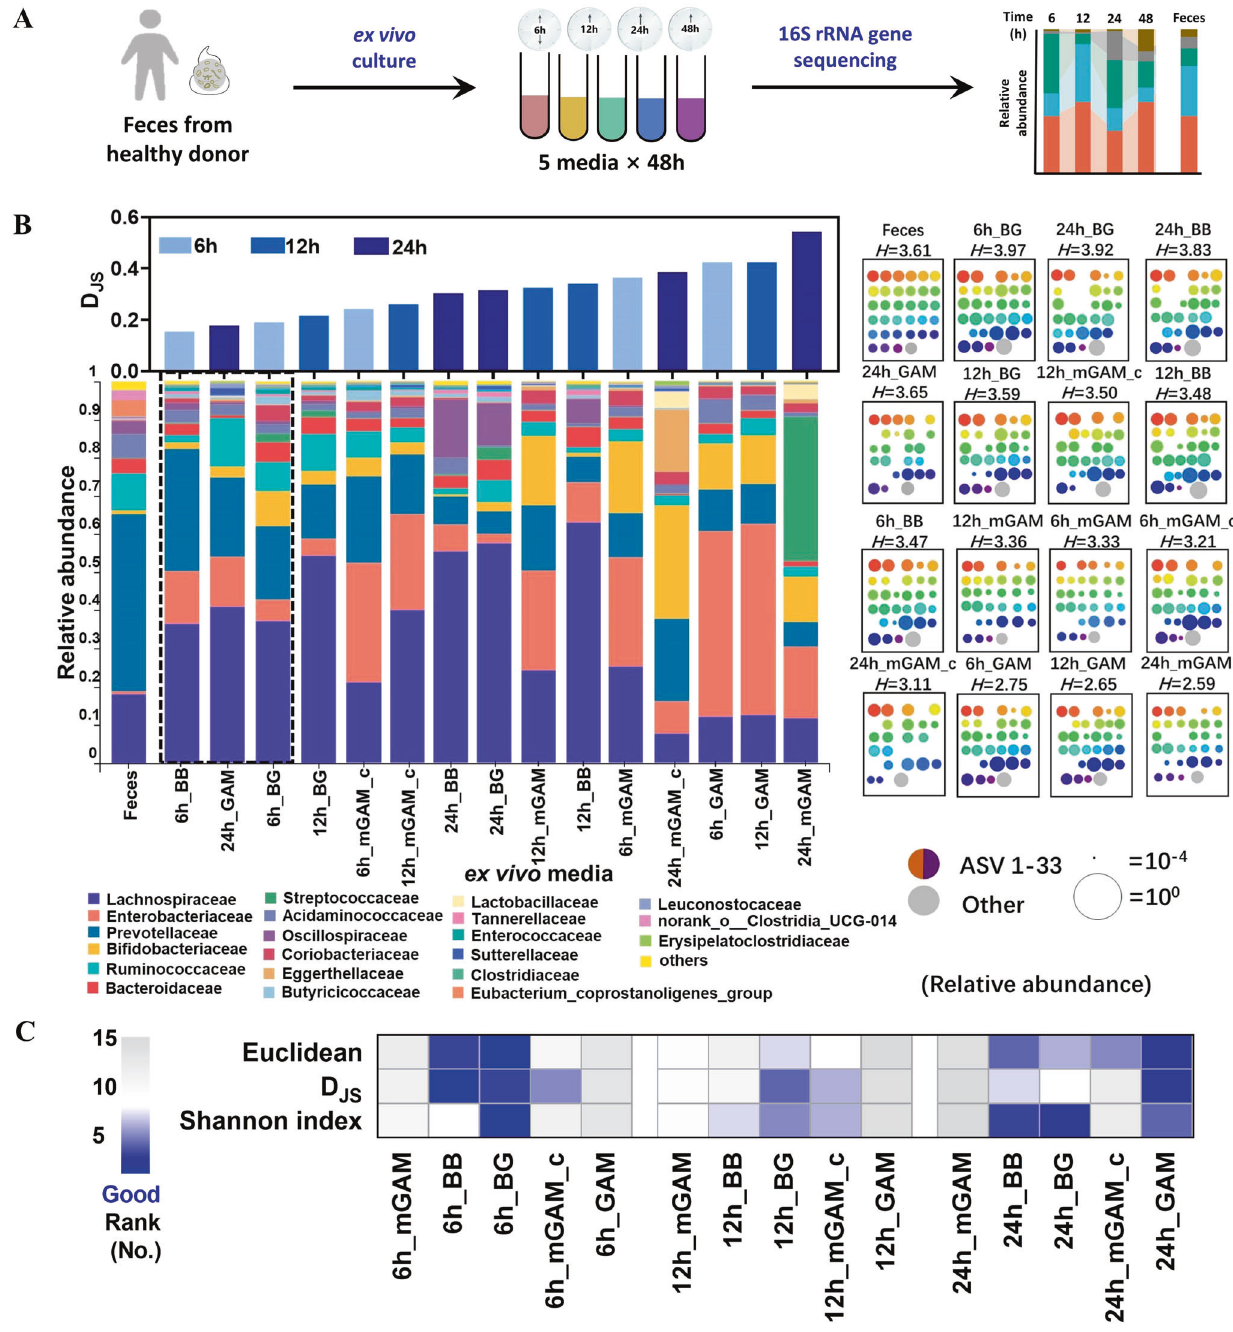
Fig. 1 Investigation of culture time for human-fecal samples. A Flow chart of the experiment B Family level bacterial composition of the sample (left), including original fecal sample and its ex vivo cultures, grown anaerobically in 5 different media at incubation time of 6,12, and 24 h. Cultures are ordered according to their Jensen-Shannon divergence (D JS ) from the original fecal sample (upper axes, computed at the family level). ASV level bacterial composition of the sample (right), where each square represents one sample. Rainbow colored dots represent the relative abundance of individual ASVs. Samples are ordered by their Shannon index at the ASV level, computed in base 2 and shown above each square. C Comprehensive rank of 15 cultures, which are ordered according to the Euclidean (ASV level) and D JS (family level) from the original fecal sample (rank from 1 to 15 in ascending order), and the Shannon index (rank from 1 to 15 in descending order), the smaller rank indicates higher similarity and higher bacterial density (Fig. S1A). Besides, the bacteria abun- time, freshly collected feces from one health donor were cultured dance in each medium at the phylum level was detected by qPCR in fi ve different media that were frequently used for culture of and compared with their corresponding fresh feces [17]. The mixed bacteria [15, 26, 27] and sampled at 6, 12, 24, and 48 h results showed that the abundance of Firmicutes was increased, (Fig. 1A). Based on the growth curve, all fi ve cultures reached whereas Bacteroidetes and Verrucomicrobia was decreased along stationary phase within 12 h, while mGAM_c and GAM showed